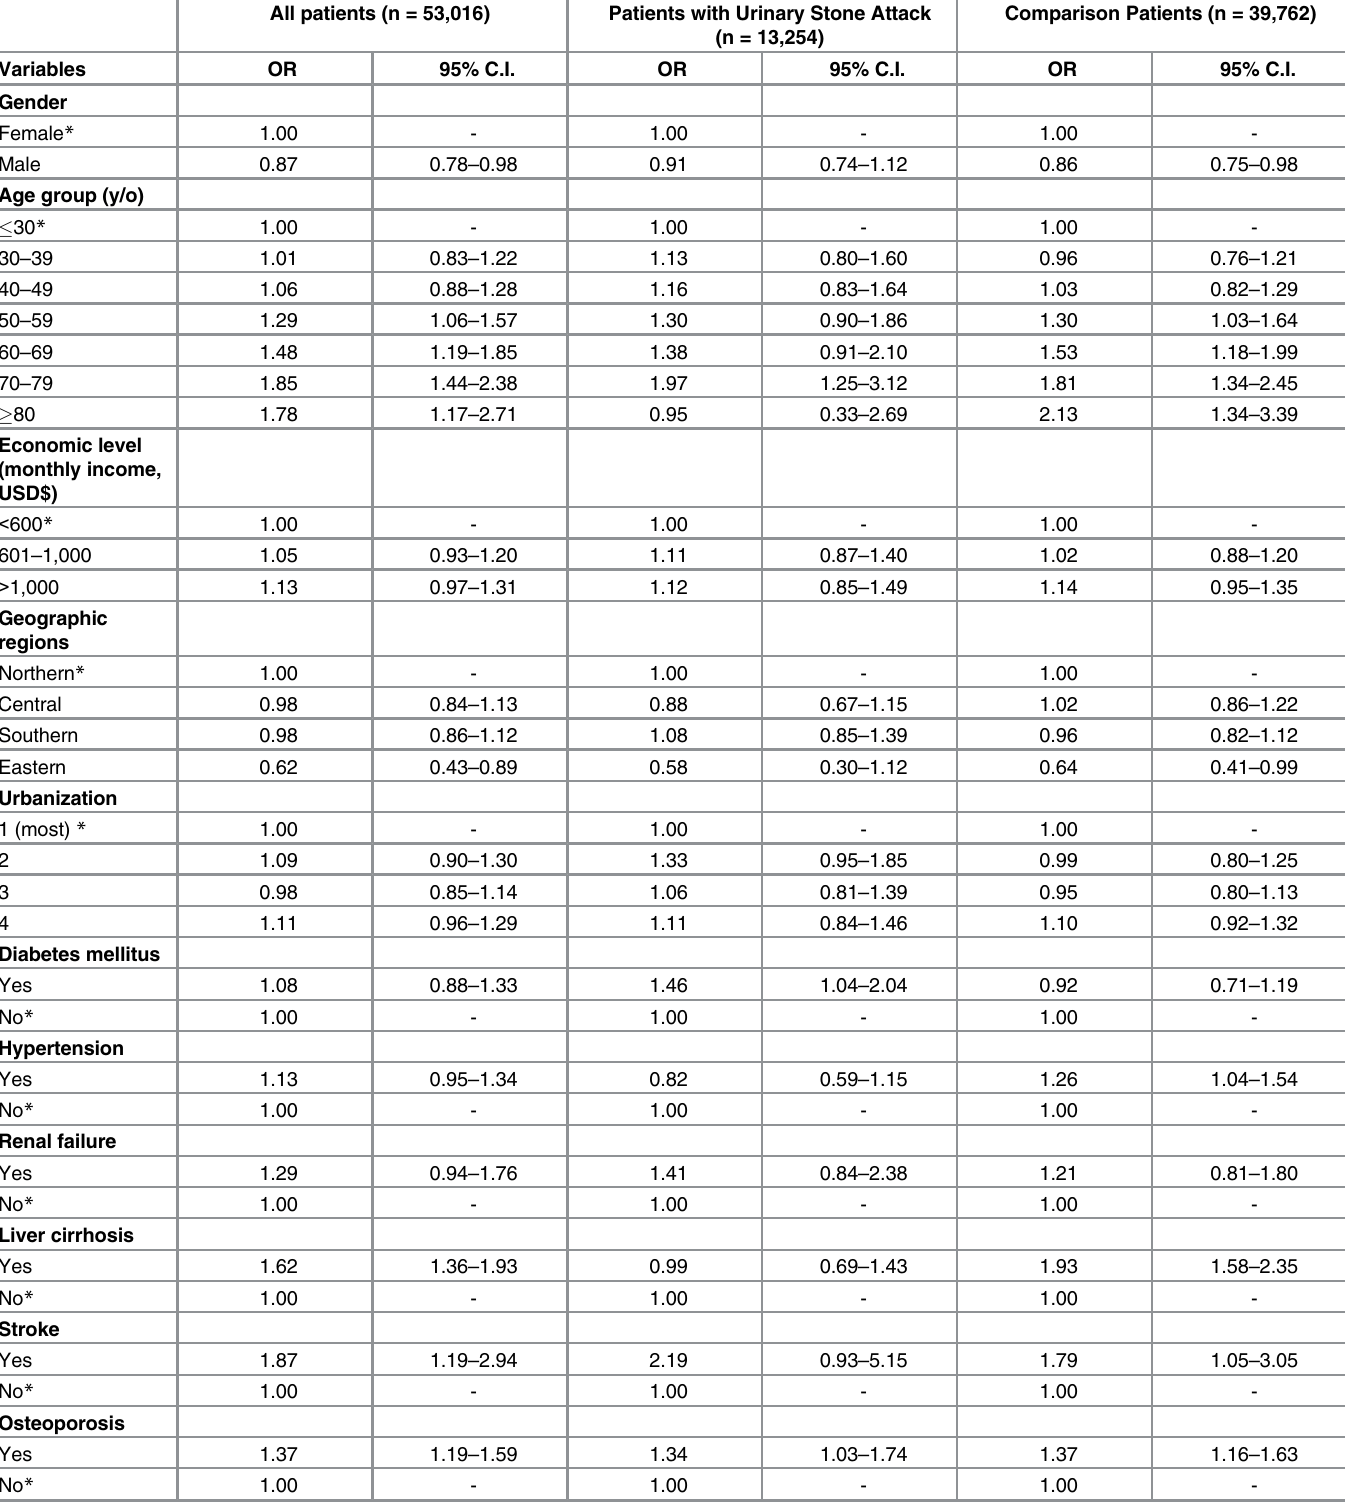
Table 5. Multiple logistic regression analysis of suffering new-onset IBS for all patients, study patients and comparison patients. All patients (n = 53,016) Patients with Urinary Stone Attack Comparison Patients (n = (n = 13,254)